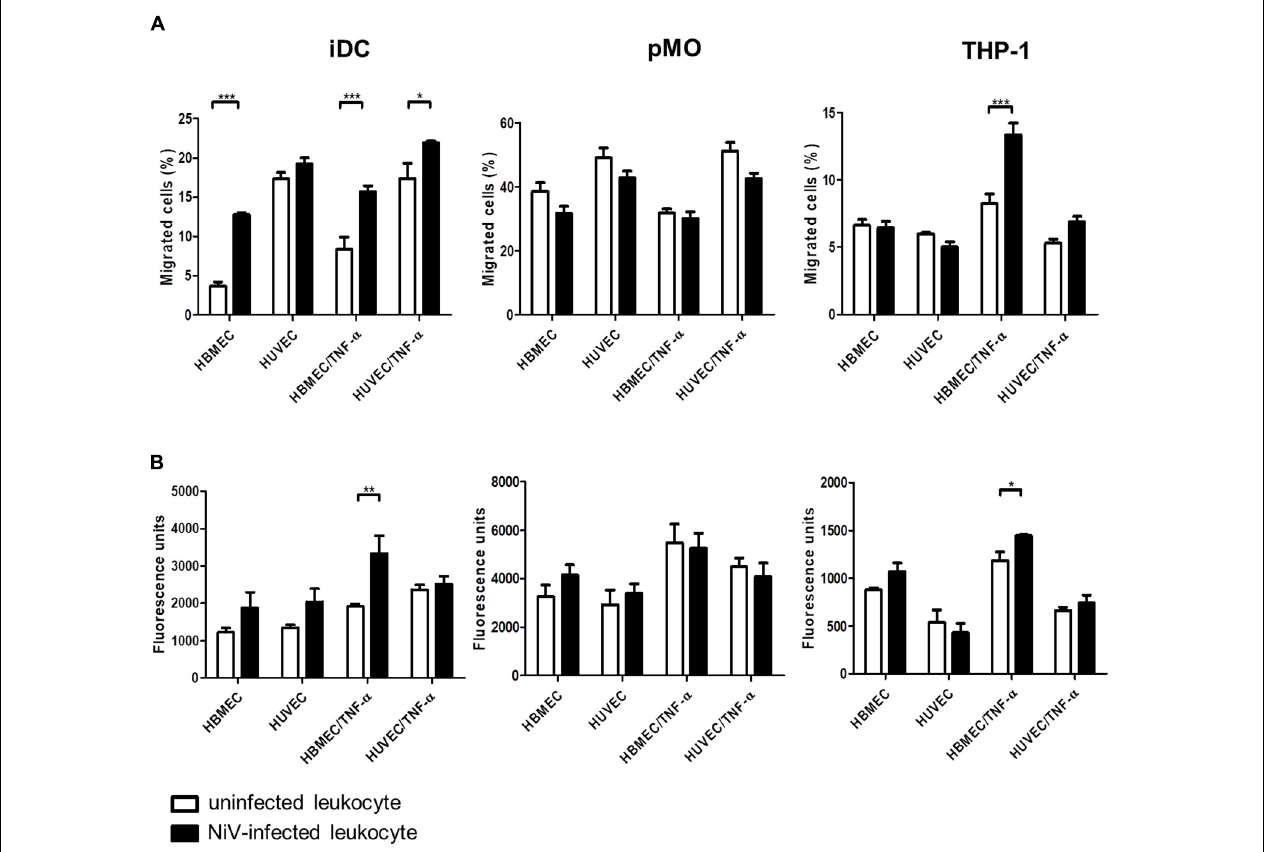
FIGURE 4 | Transendothelial migration of iDC, pMO, and THP-1, either mock-infected or infected with NiV, across untreated and TNF- α -treated HBMEC and HUVEC: (A) migration was presented as the percentage of migrated cells [represented on the y-axis as migrated cells (%)], and (B) permeability of endothelial monolayers after transendothelial migration as measured by the flux of 70 kDa fluorescein-dextran (represented on the y-axis as fluorescence units). Values are the average of three biological replicates and error bars indicate standard deviation ( ∗ p < 0.05, ∗∗ p < 0.01, ∗∗∗ p < 0.001). Data is representative of two independent biological